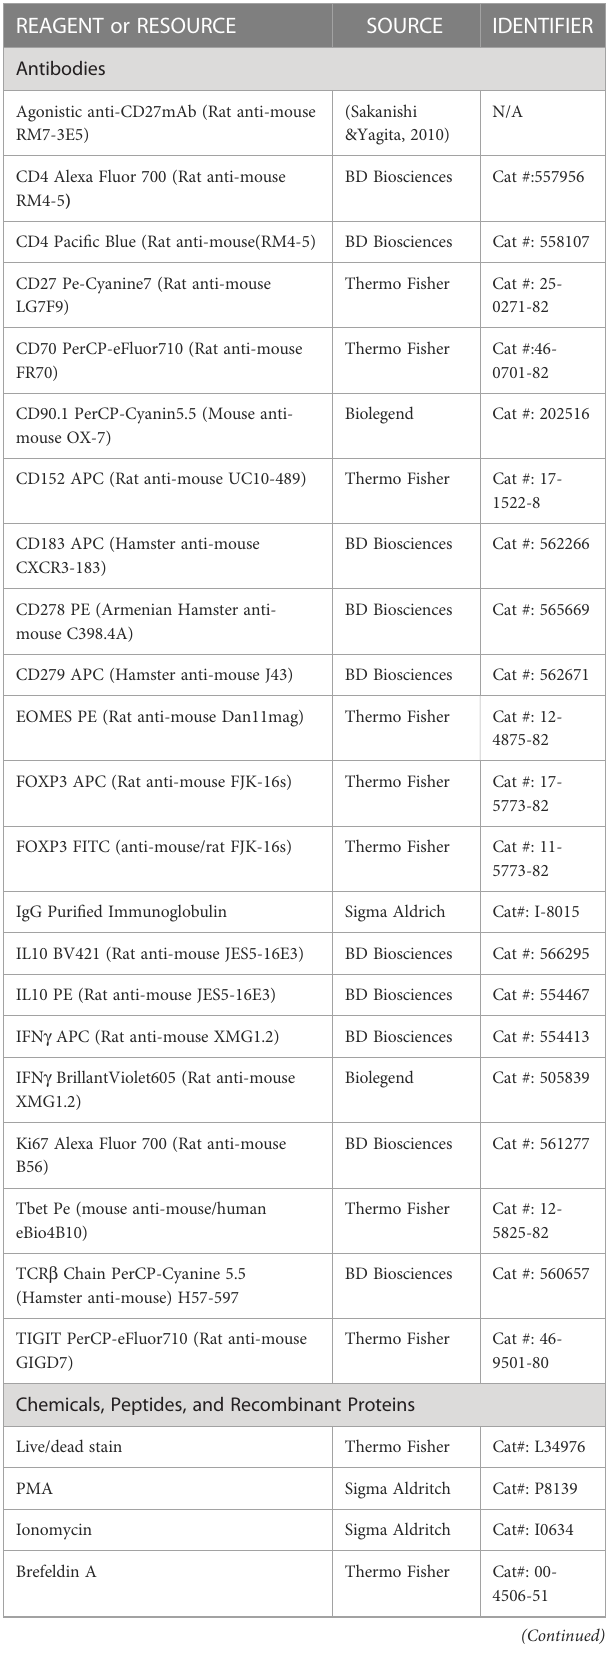
TABLE 1 List of reagents and